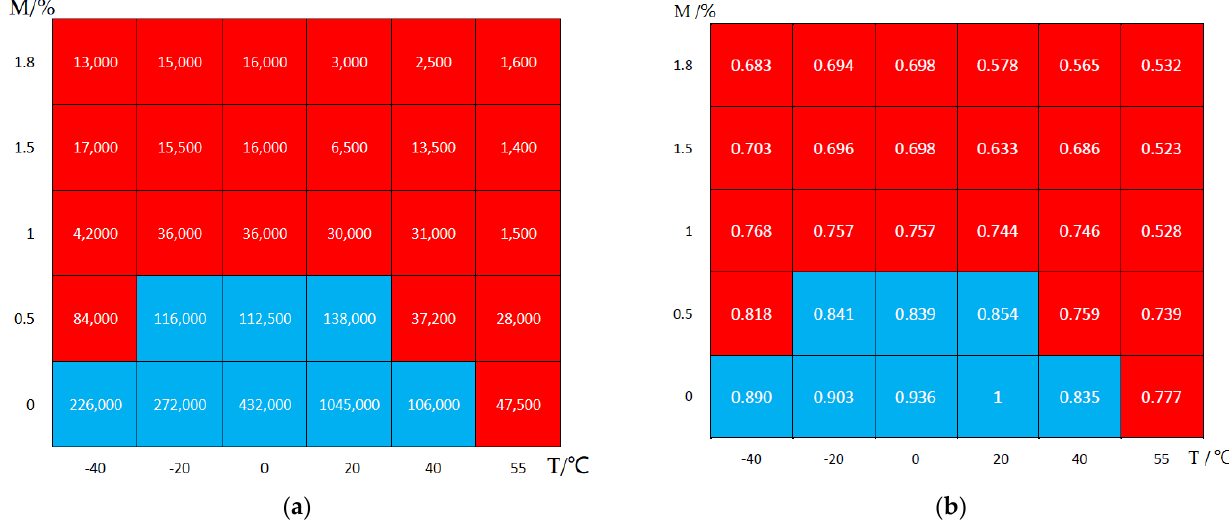
Figure 9. Fatigue failure process calculated by the finite element method. ( a ) RTD; ( b ) CTD; ( c ) ETW.